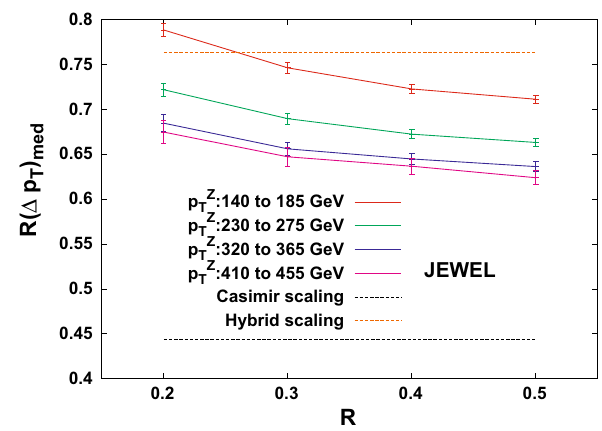
Fig. 3 R (Δ p T ) med as a function of the initial parton p T